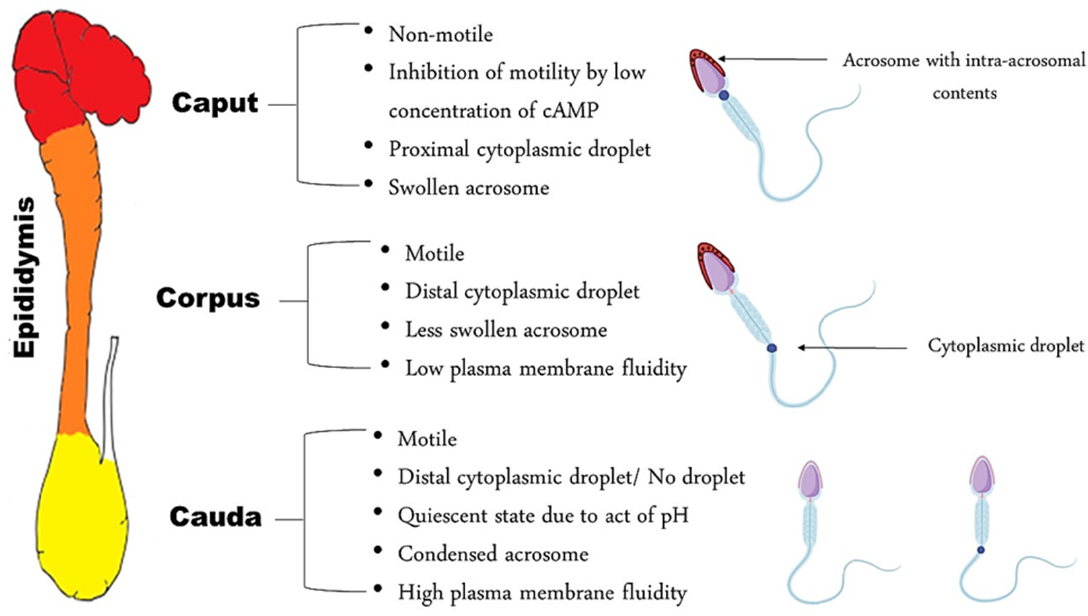
Figure 1. Schematic representation of spermatozoa characteristics in each epididymal segment.